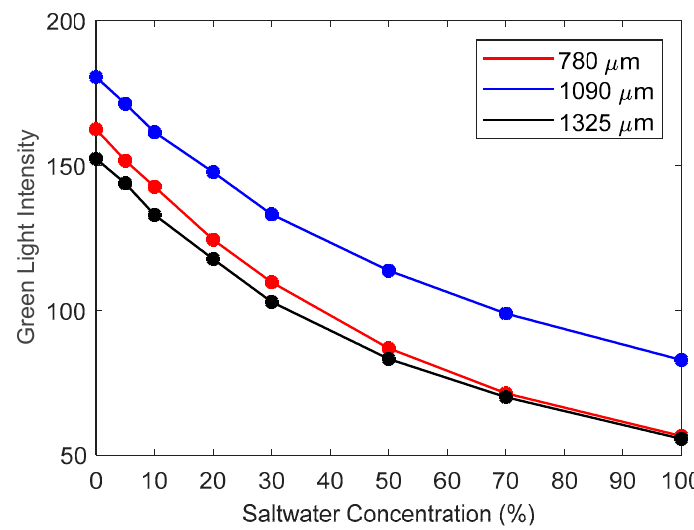
Figure 8. Average values of green light intensity of the three homogeneous aquifers for each corresponding calibration concentration.